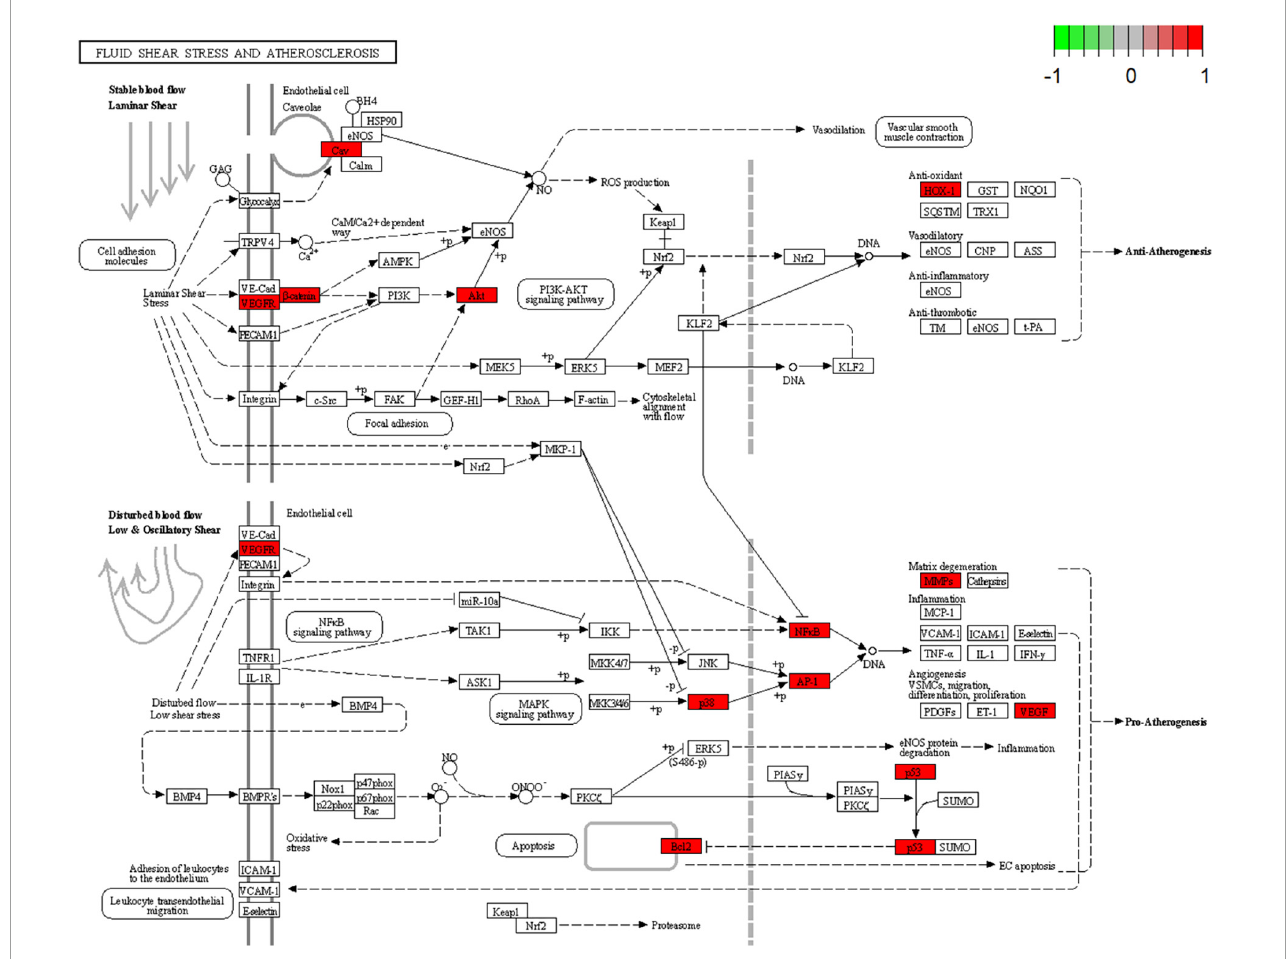
FIGURE7 Fluid shear stress and atherosclerosis signaling pathway. Red represents the intersection targets of THD against AS in the signaling